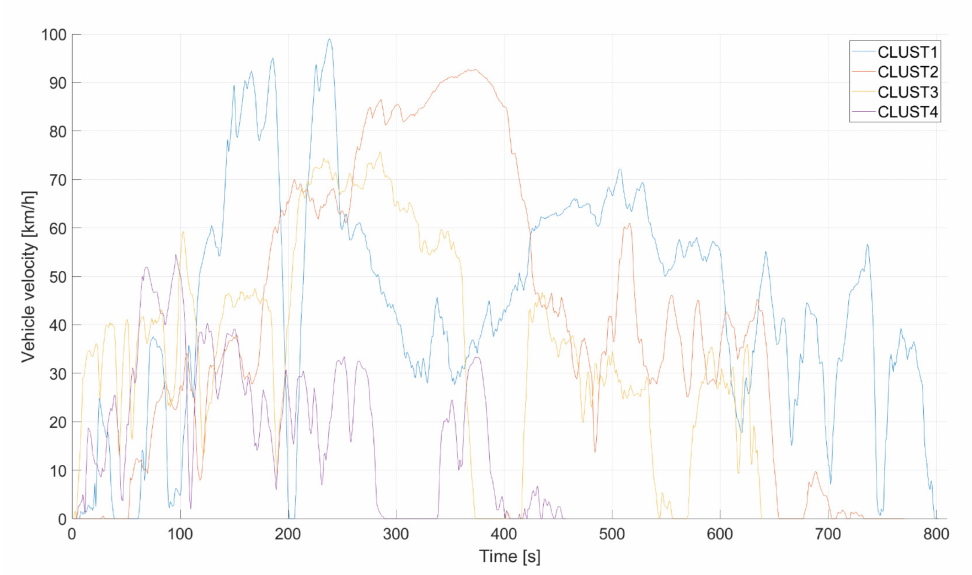
Figure 4. Comparison of the vehicle velocity trajectories as a function of the mission time between CLUST1, CLUST2, CLUST3 and CLUST4.